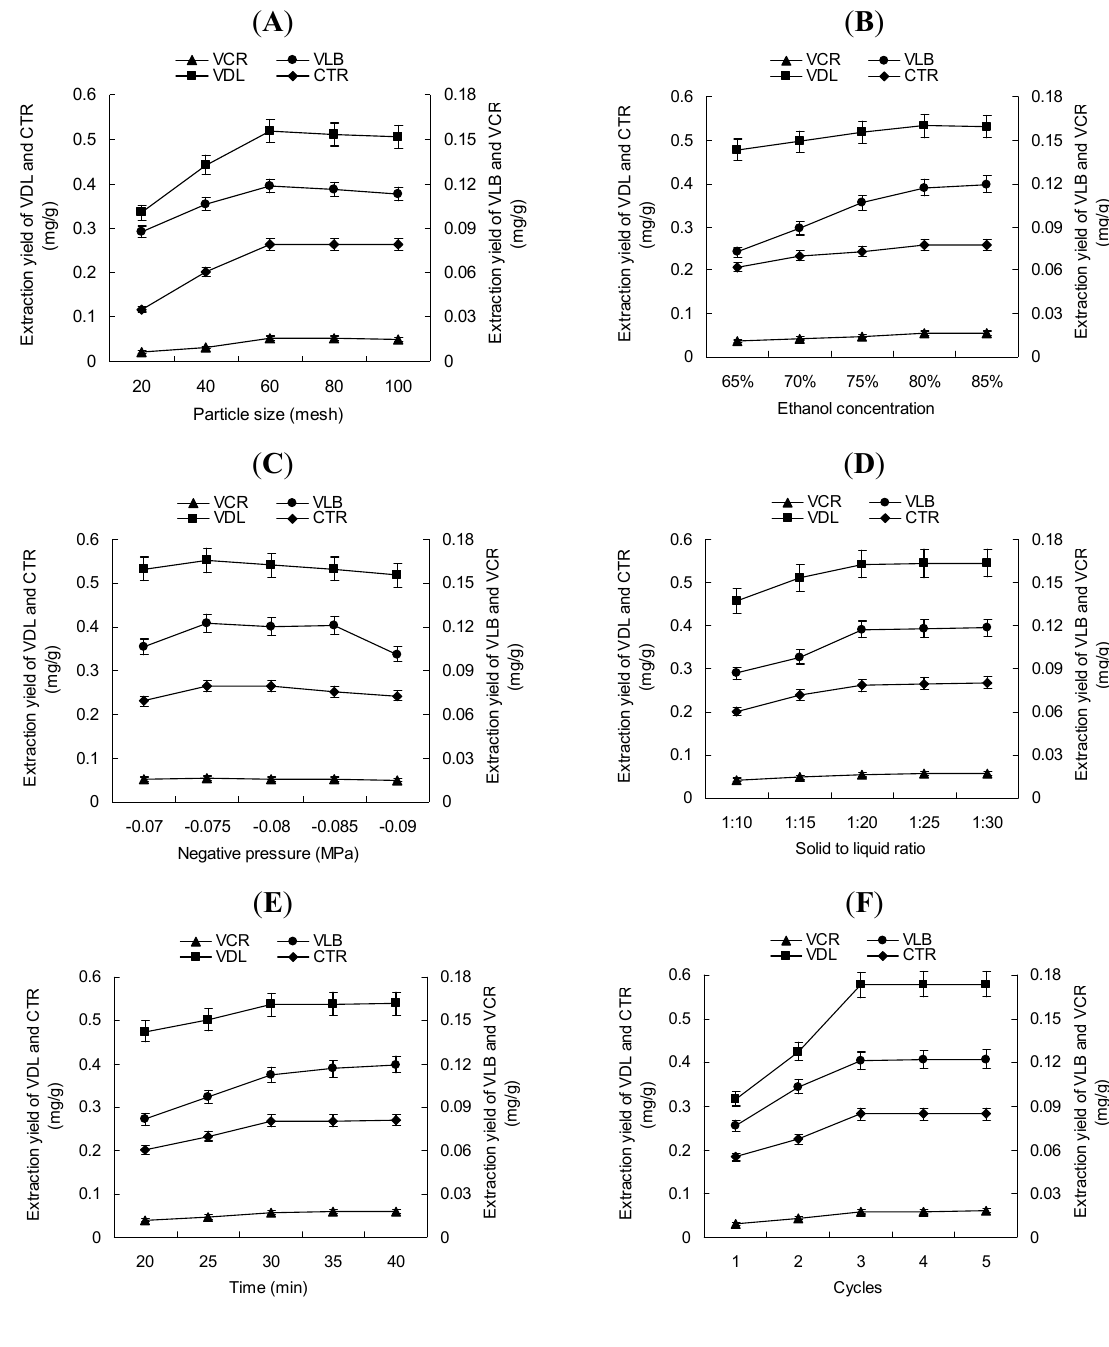
Figure 2. Effect of ( A ) particle size, ( B ) ethanol concentration, ( C ) negative pressure, ( D ) solid to liquid ratio, ( E ) time and ( F ) number of cycles on the yields of VDL, CTR, VCR and VLB of